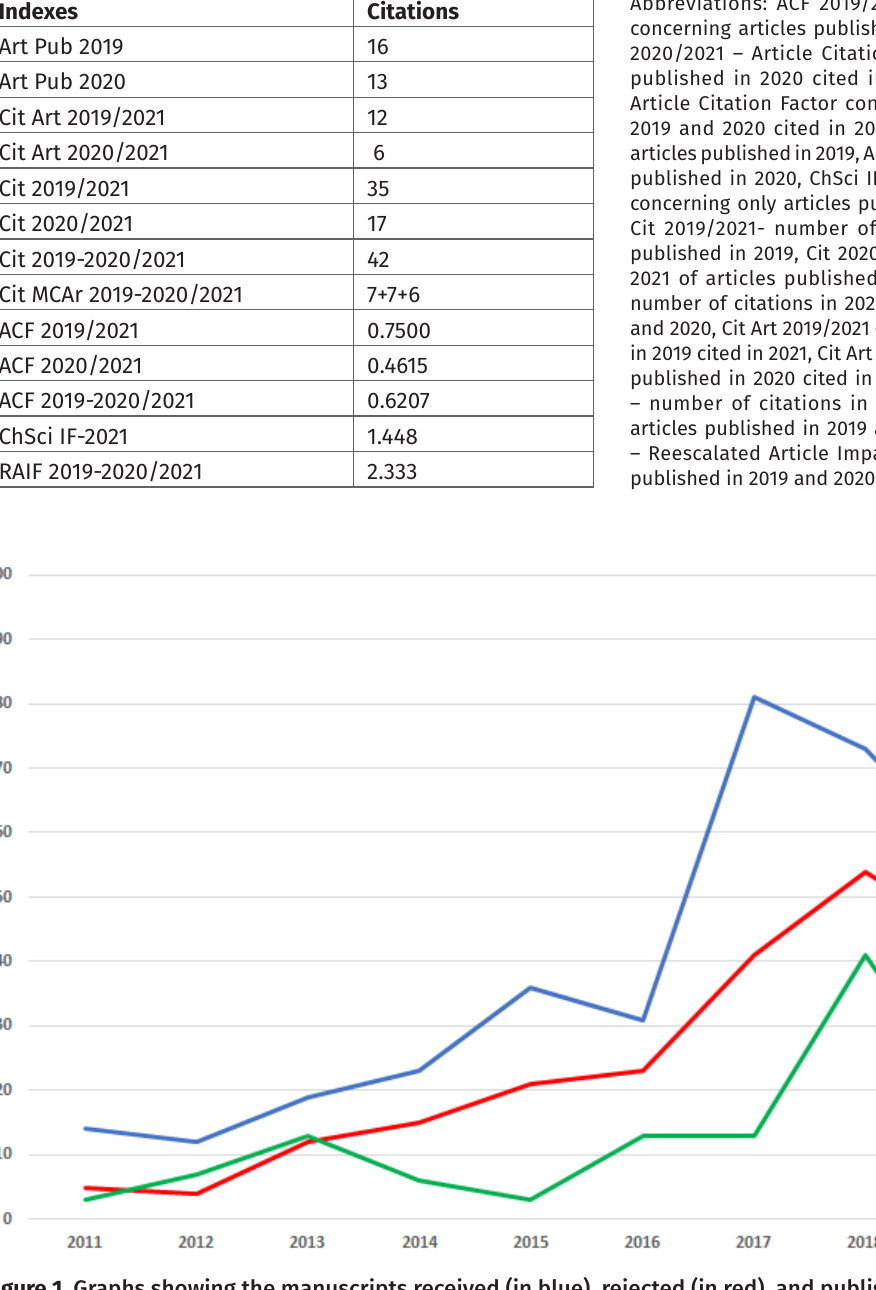
Figure 1. Graphs showing the manuscripts received (in blue), rejected (in red), and published (in green) by the Annals of the Academy of Sciences (AABC) in Chemical Sciences between 2011 and